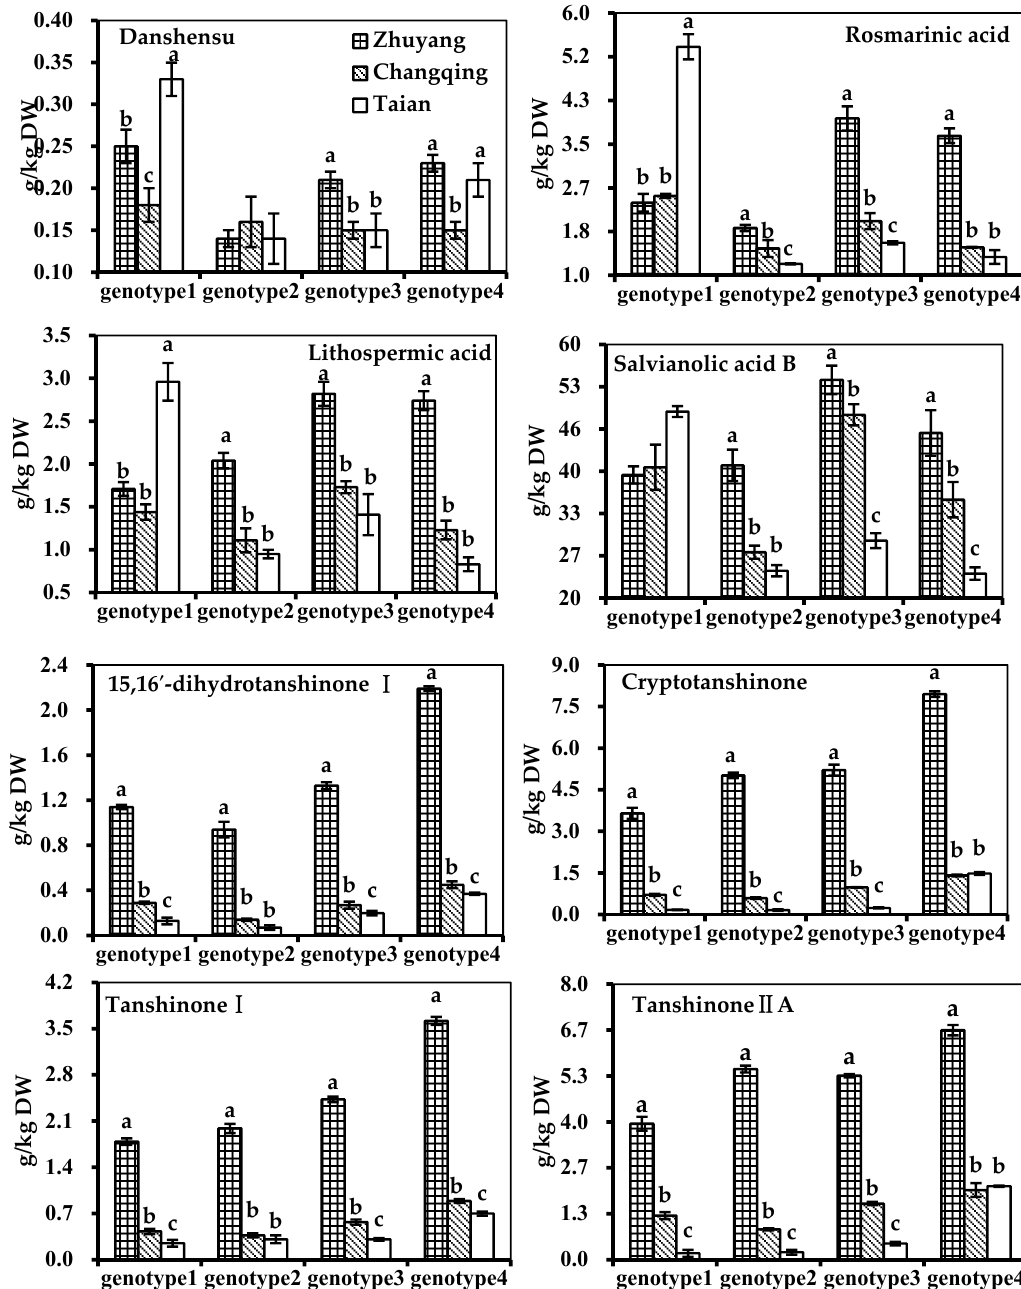
Figure 3. Absolute quantification of eight selected metabolites. Concentrations are given in g/kg DW. Data are shown as mean of concentration ± SD. Values between three locations having different lowercase letters (a, b, and c) are significantly different at p < 0.001/3 (Bonferroni correction).